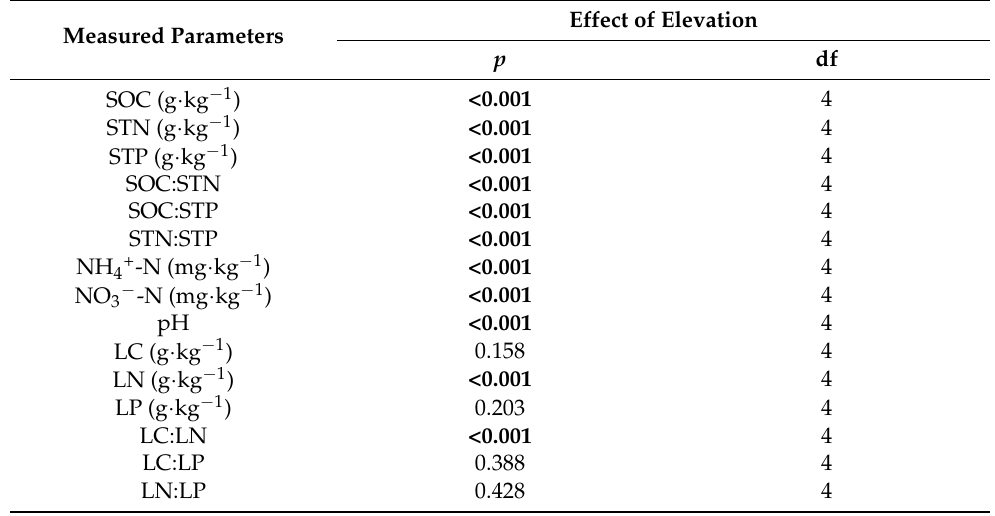
Table 1. Effects of elevation on soil properties and leaf stoichiometric characteristics of P. crassifolia . Measured